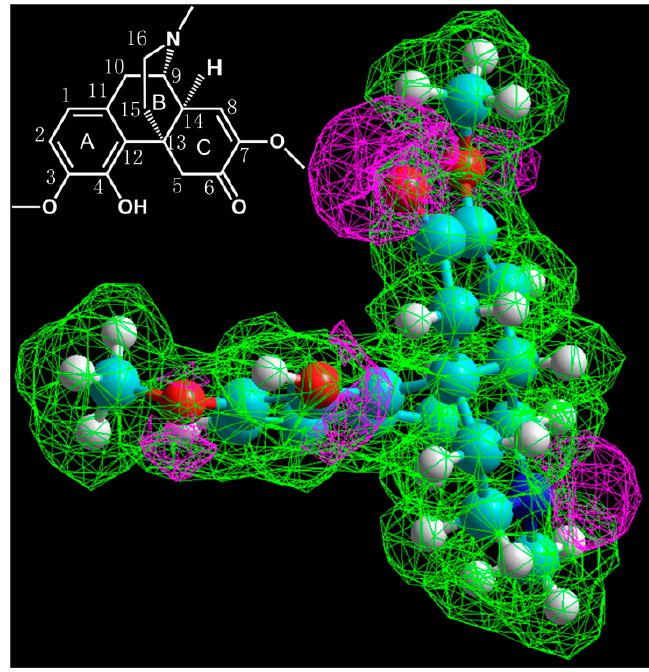
Figure 2. The electrostatic potential plot of the compound model optimized by semi-empirical method, AM1. Purple indicates negative potential while green indicates positive potential. The sites with negative potential were amine group, carbonyl group, hydroxyl group, and ether groups where the initial protonation could happen most likely.